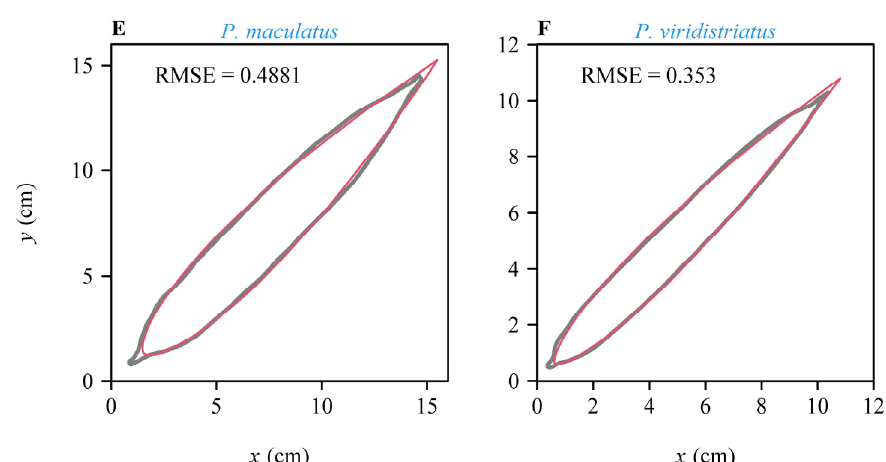
Figure 2. Illustration of the results of fitting the boundary coordinates of representative leaf samples for the six studied bamboo species (the same leaves as shown in Figure 1) using SGE-1. The gray curves are the actual scanned leaf boundaries; the red curves are the leaf boundaries predicted by the model SGE-1, i.e., Equation (3).